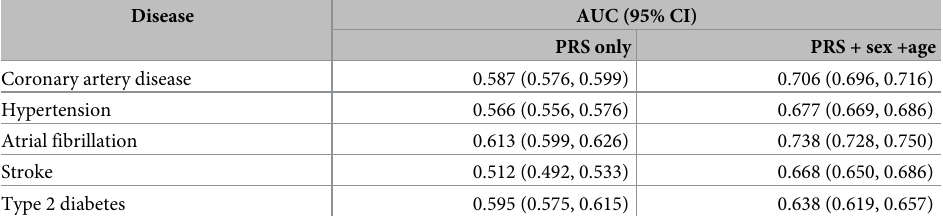
Table 7. Predictive performance of the SCT PRSs in the testing data, with and without including age and